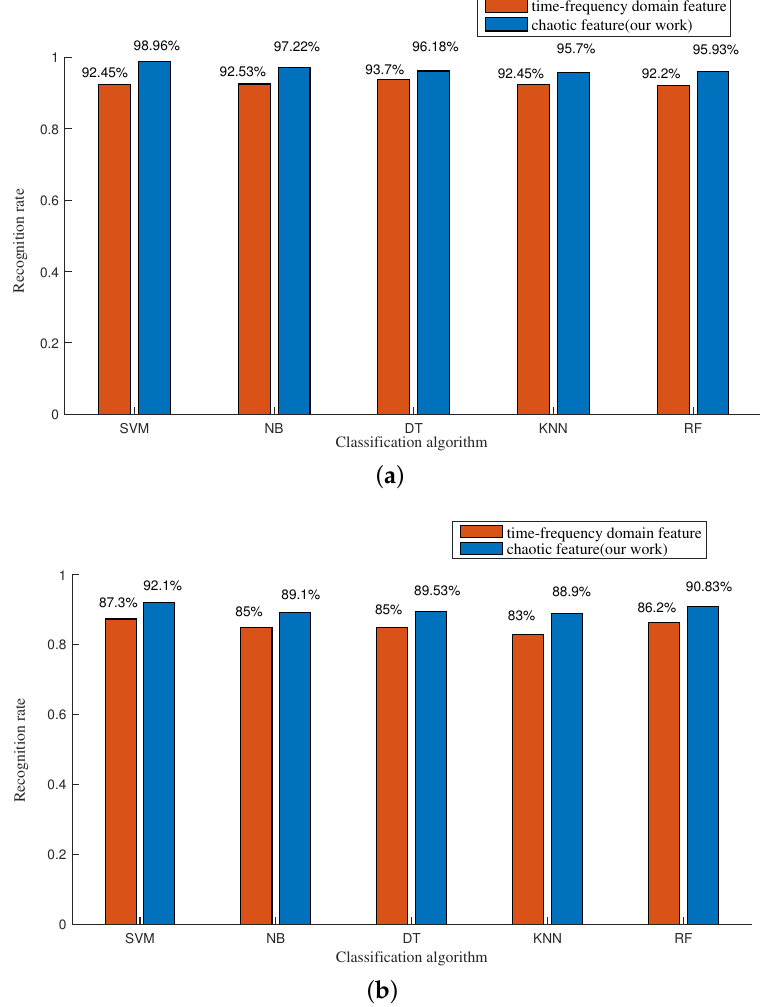
Figure 8. Comparison of recognition result. ( a ) basic activity; ( b ) transition